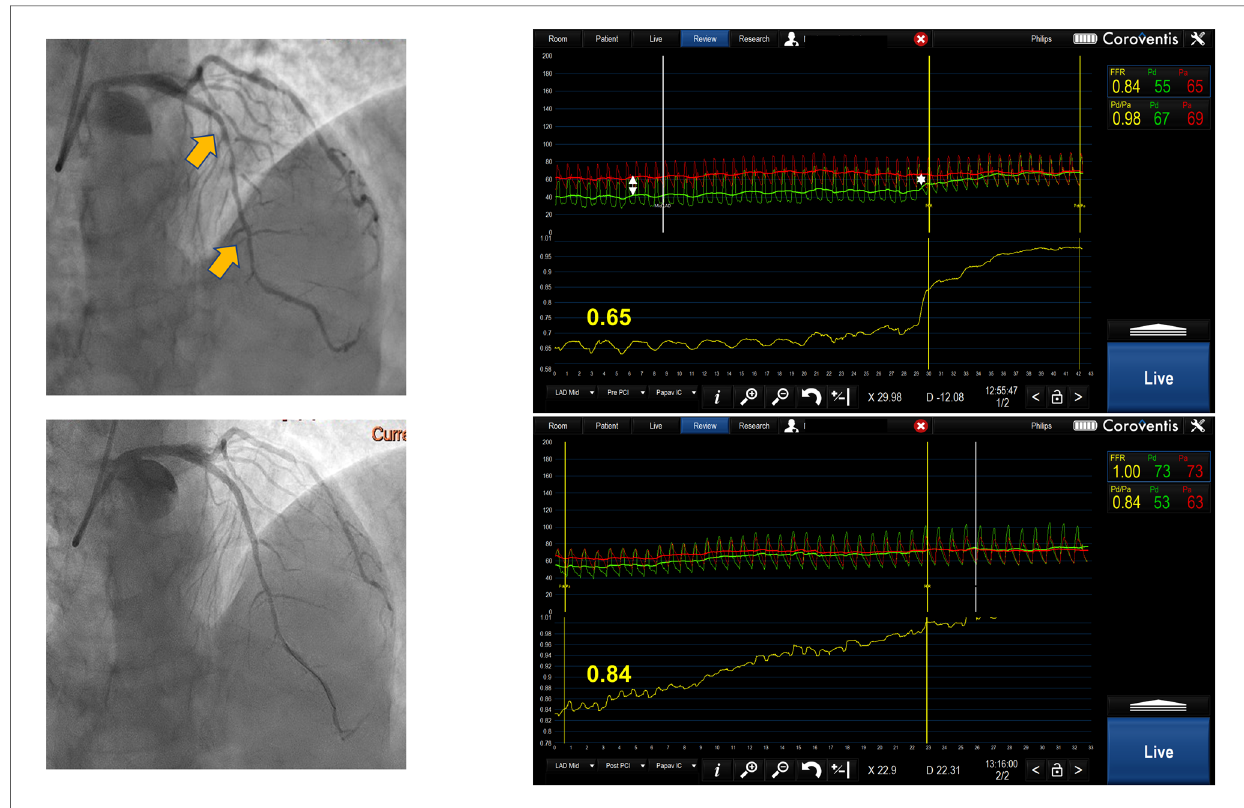
FIGURE 2 Serial lesion assessment by pullback FFR measurement using Coroventis CoroFlow cardiovascular software (Coroventis AB, Uppsala, Sweden), followed by PCI of the lesion with greatest Δ P and retesting after stent implantation leading to the deferral of further intervention due to an increase in